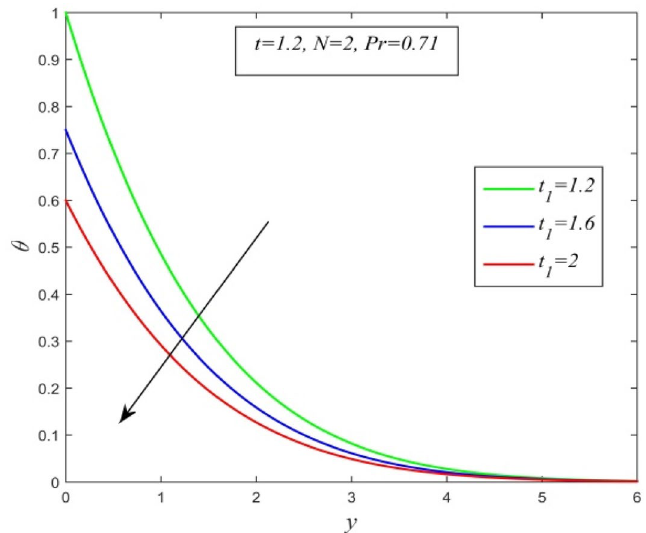
Figure 41. temperature field versus y for different t 1 when t = 1.2, N = 2, Pr = 0.71 , Sc = 0, Du = 0,K = 0.